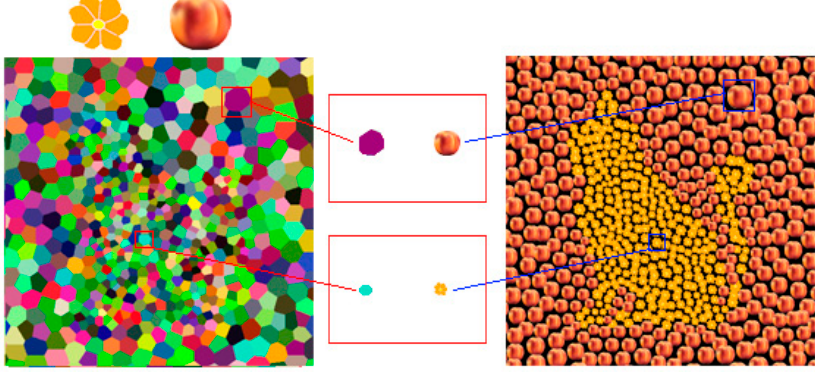
Figure 13. Putting the elements into Voronoi regions after adjusting the sizes.